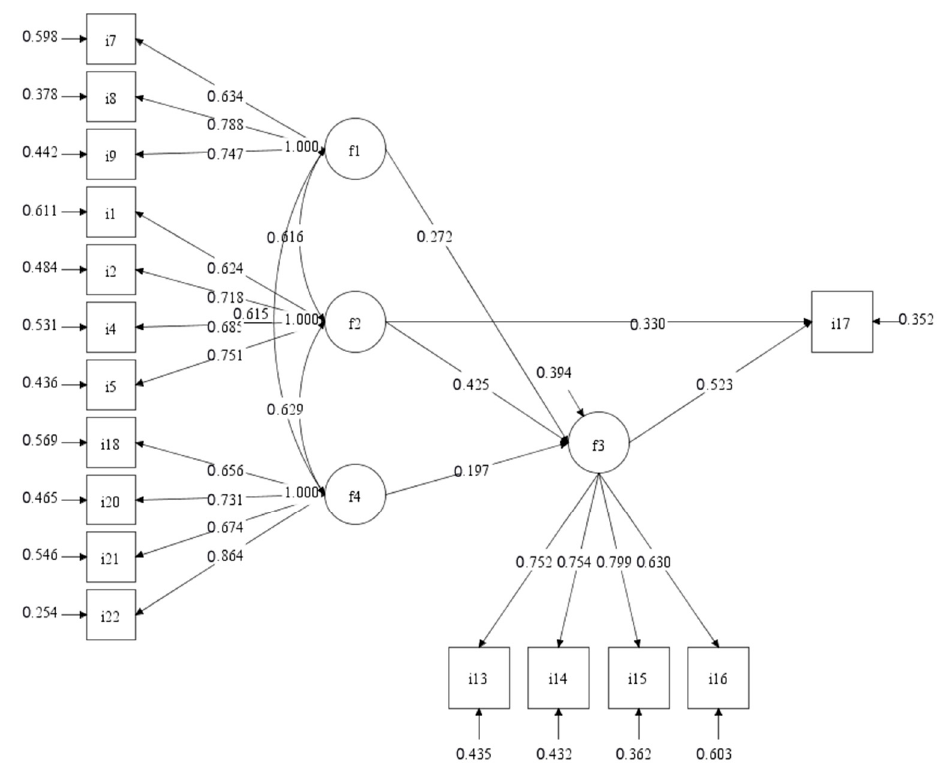
Figure 3. Path diagram of the structural equation model of residents’ satisfaction.